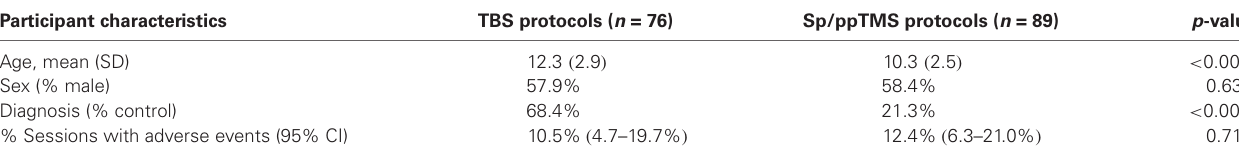
Table 1 | All participant characteristics and adverse events . Participant characteristics